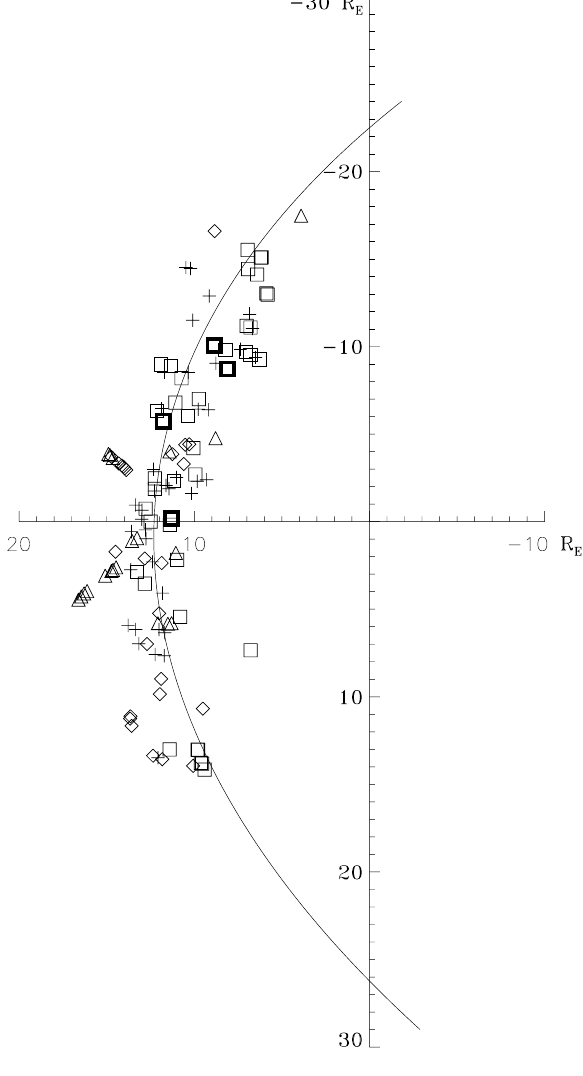
Fig. 1. Positions of the 132 AMPTE IRM bow shock crossings rotated into the ecliptic plane: quasi-parallel are + signs; quasi- perpendicular low- β ( β < 0 . 5) are triangles,; quasi-perpendicular medium- β (0 . 5 < β < 1 . 0) are diamonds; quasi-perpendicular high- β ( β > 1 . 0) are squares; bold squares are events, where mirror modes have clearly been identified. The hyperbola is the best-fit hyperbola through the crossings with multiple crossings weighted as one